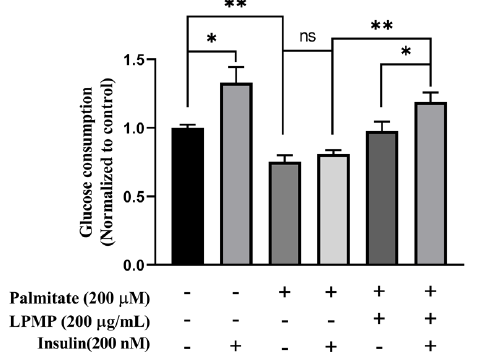
Figure 4. Effect of LPMP on improving insulin resistance in HepG2 cells. In the absence or presence of LPMP, HepG2 cells were treated with 200 μ M PA for 24 h. Then, cells were incubated for a further 4 h with or without 200 nM insulin at 37 °C. Cellular glucose consumption was determined by detecting the reduction of glucose in the culture medium. Data are presented as means ± SEM ( n = 5). * p < 0.05, ** p < 0.01.